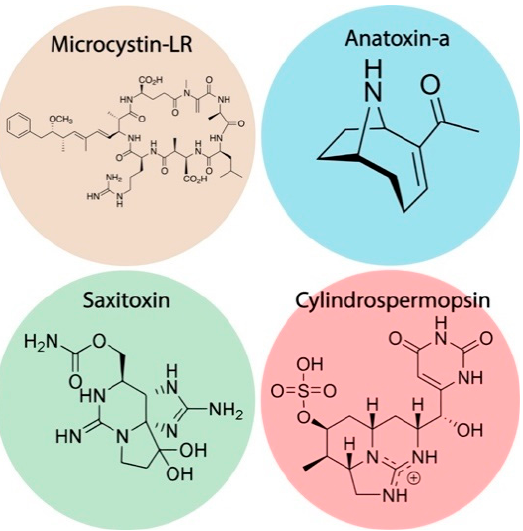
Figure 1. Chemical structures of major relevant cyanotoxins in environmental and food samples.